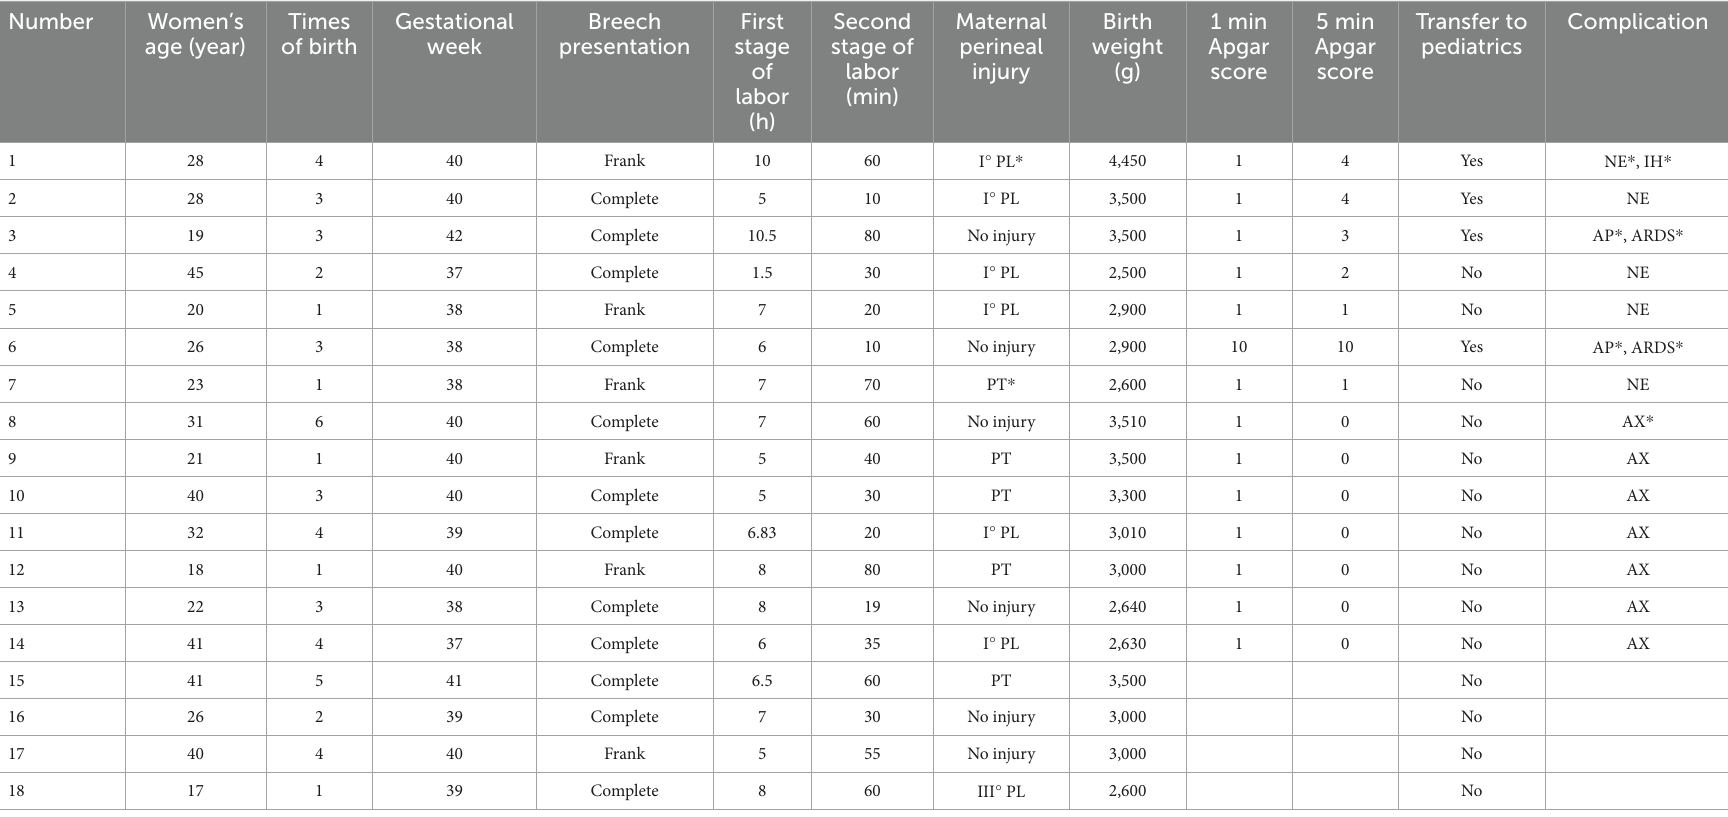
TABLE 6 Basic information of 18 dead